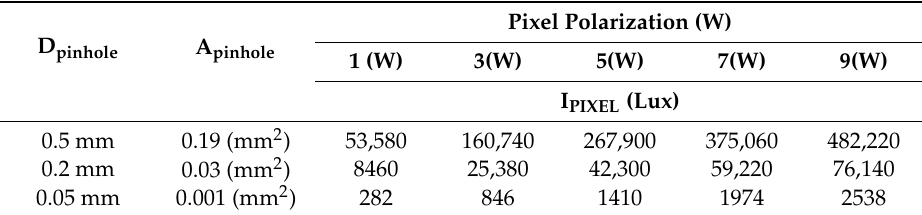
Table 3. Calculations of the light budget within the sensor for different pinhole diameters and different LED polarization power. Assuming that the six LEDs are on, the different light flux intensities at the pixel are